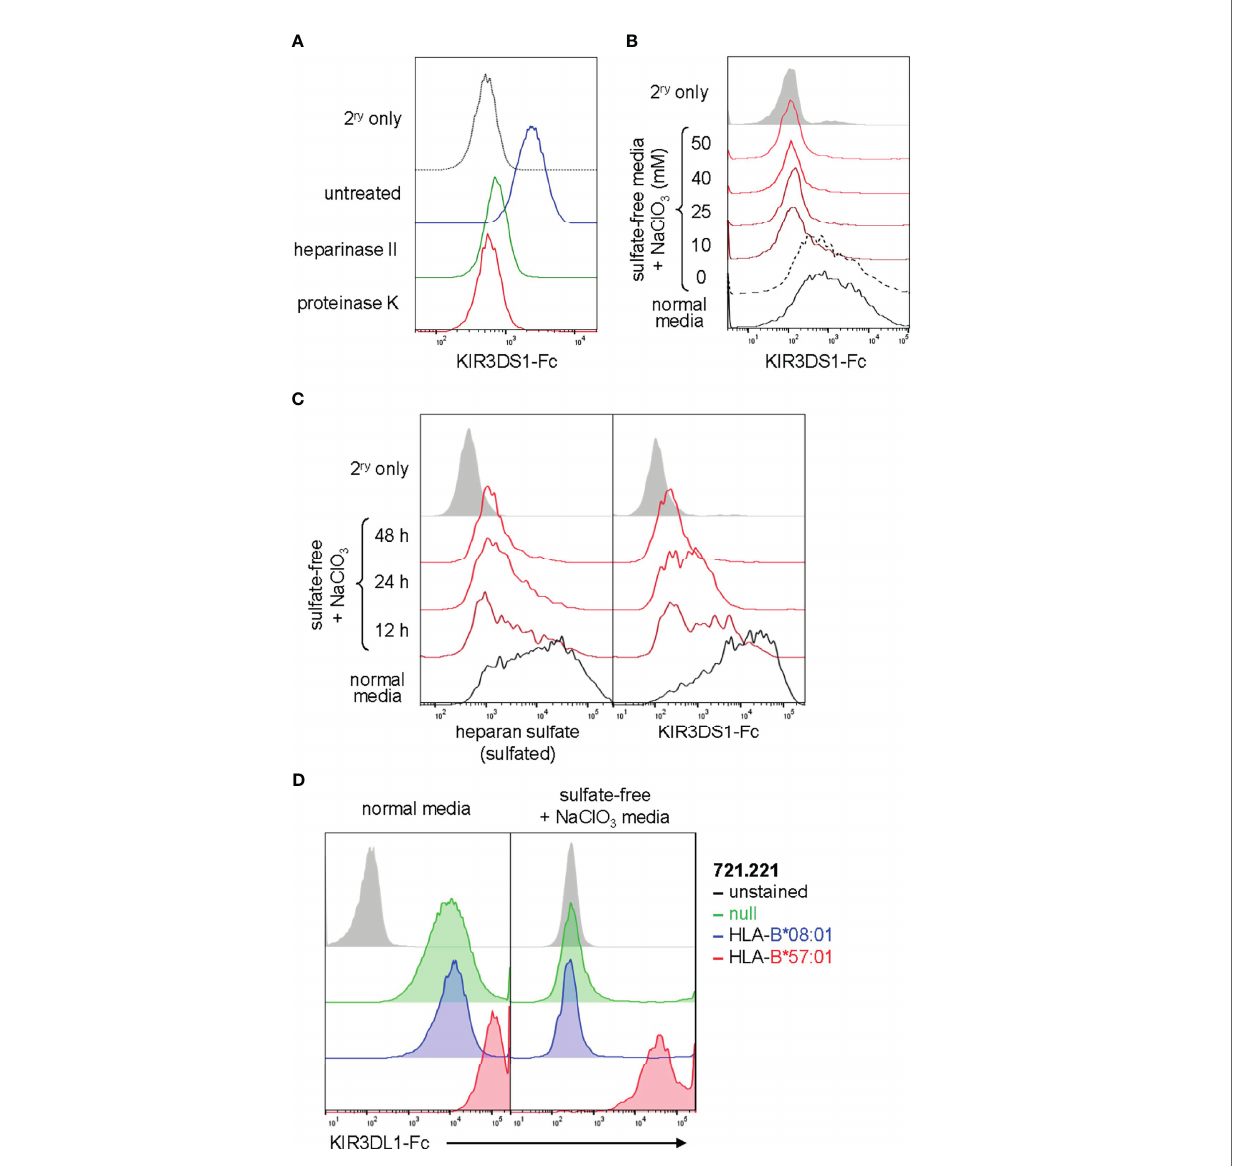
FIGURE 3 | KIR binding to heparan sulfate on cells can be abrogated by heparan sulfate degradation or sulfation inhibition and is independent of binding to known HLA ligands. (A) Flow histogram of 721.221 cells treated with heparinase II, proteinase K, or no enzyme and stained with KIR3DS1-Fc (25 m g/mL). (B) EBV-BCL cells were cultured for 48 h in sulfate-free media containing the indicated concentrations (in mM) of NaClO 3 , and then stained with KIR3DS1-Fc (25 m g/mL). (C) Human donor-derived EBV-BCL cells were cultured for the indicated amounts of time with sulfate-free media containing 50 mM NaClO 3 or regular media and separately stained with anti-heparan sulfate antibody (clone: 10E4) and KIR3DS1-Fc (25 m g/mL). (D) 721.221 cells that were untransduced or transduced with HLA-B*08:01 or HLA-B*57:01 were cultured in regular media or in sulfate-free/NaClO 3 -containing media and stained with KIR3DL1-Fc (25 m